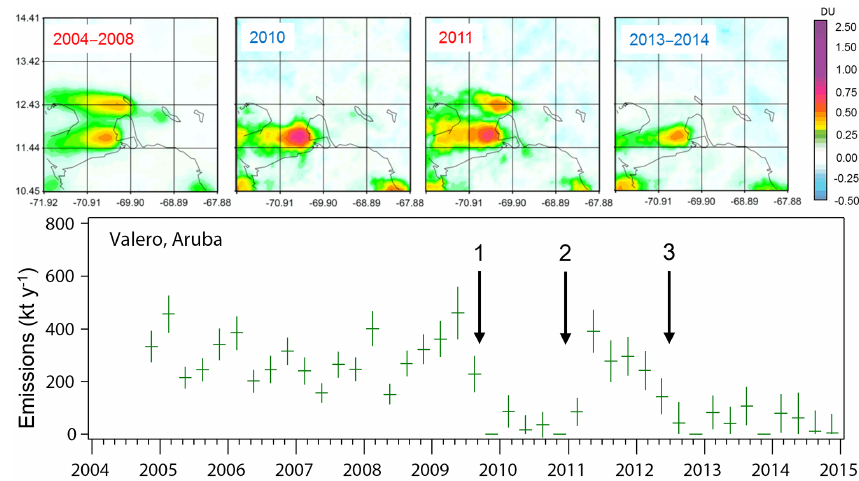
Figure 7. Top: mean SO 2 maps near the Valero refinery, Aruba, located at the centre, for different time intervals. Years when the refinery was operational are labelled in red, and years when it was idle are labelled in blue. The Paraguaná refinery complex, Venezuela, and Isla refinery, Curacao, are responsible for the SO 2 hotspots located south and east of Aruba, respectively. Bottom: time series of Valero SO 2 emission rates estimated from OMI. Each symbol represents an estimate for a 3-month period with 2 σ error bars. The refinery was shut down temporarily in July 2009 (marked by arrow 1), reopened in late 2010 (arrow 2), and was then converted to a product terminal starting in March 2012 (arrow